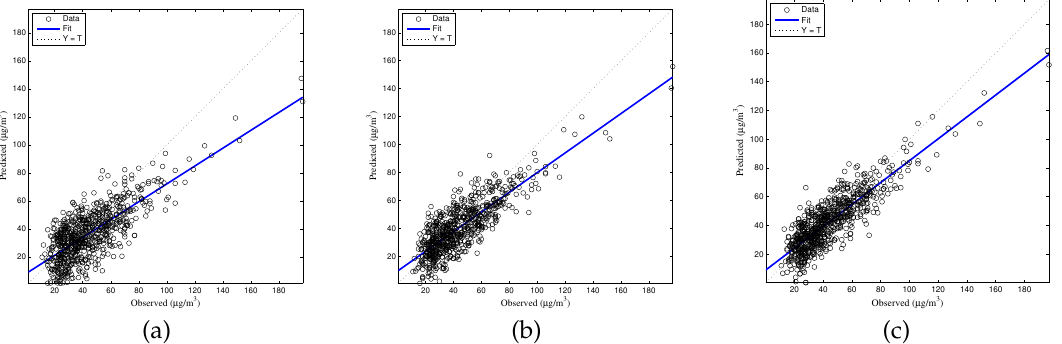
Figure 6. Comparison of prediction results among MLR, FFANN-BP, and ELM. PM 2.5 predictions ( a ) MLR; ( b ) FFANN-BP; ( c ) ELM.